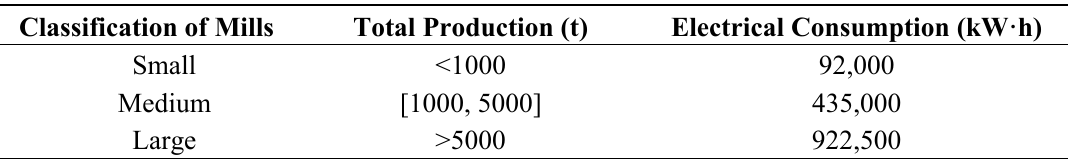
Table 1. Classification of olive mills based on total production. The average electrical consumption is indicated for each group